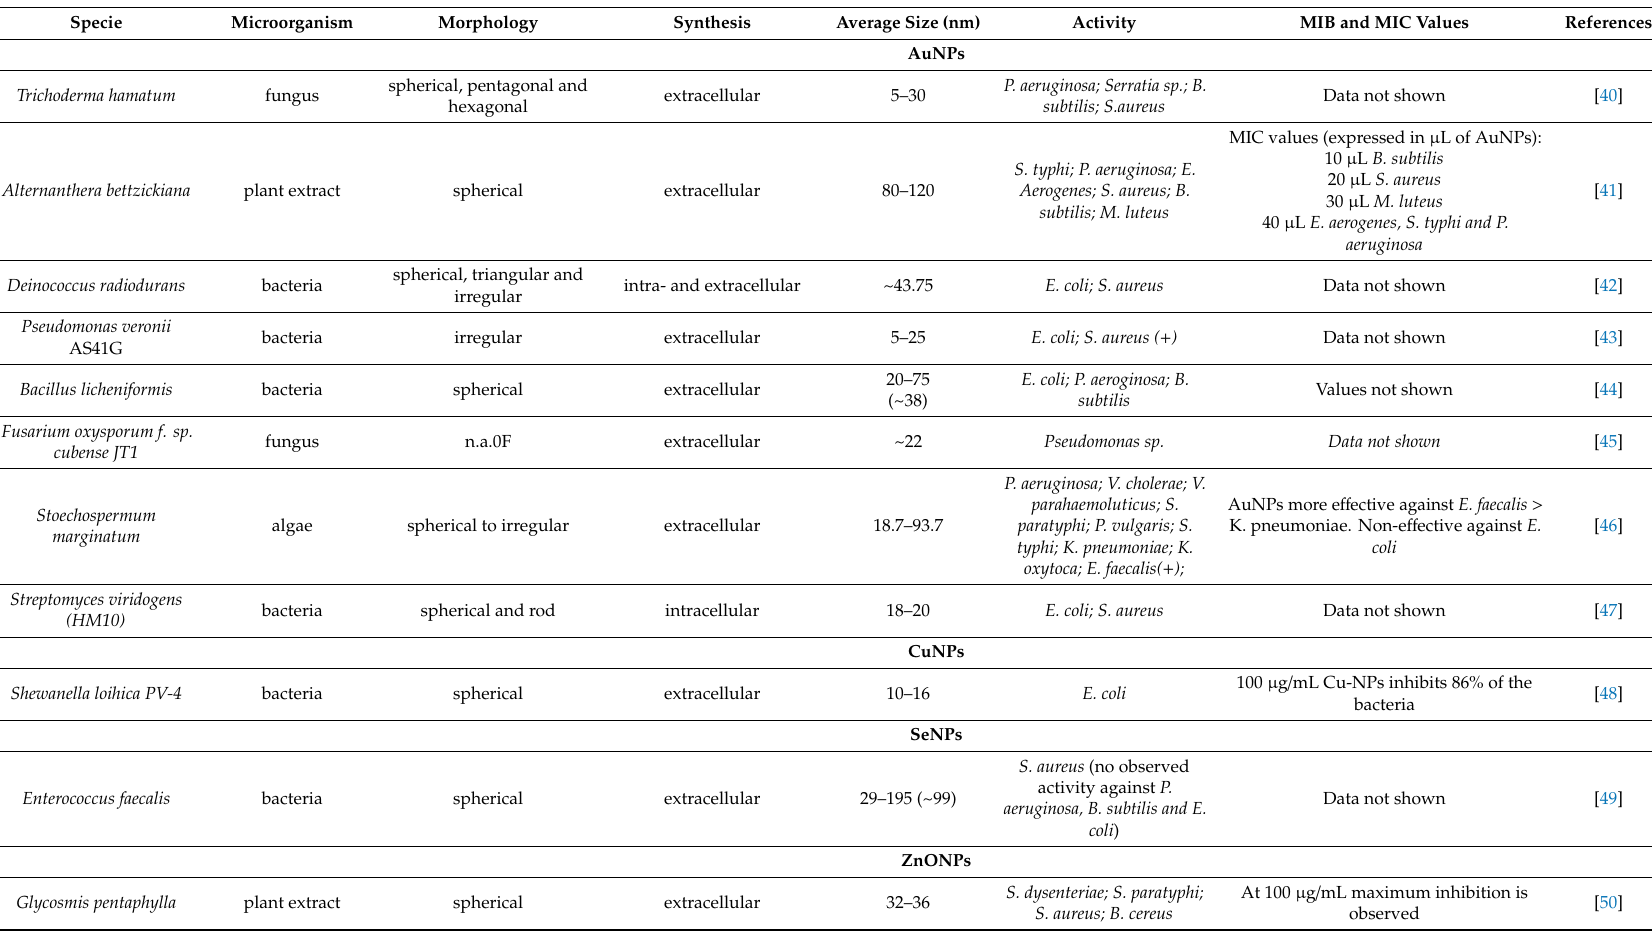
Table 1. Examples of green synthesis of alternative metal-based nanoparticles with potential antibacterial activity, with respective minimum inhibitory concentration (MIC) and minimum bactericidal concentration (MBC)